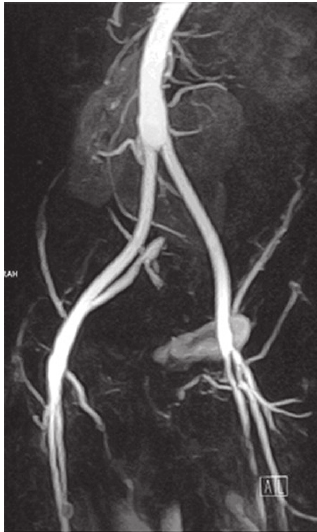
Fig. 2 - Ressonância magnética de angiografia identificando anastomose proximal término-lateral acima do nível das artérias renais acessórias